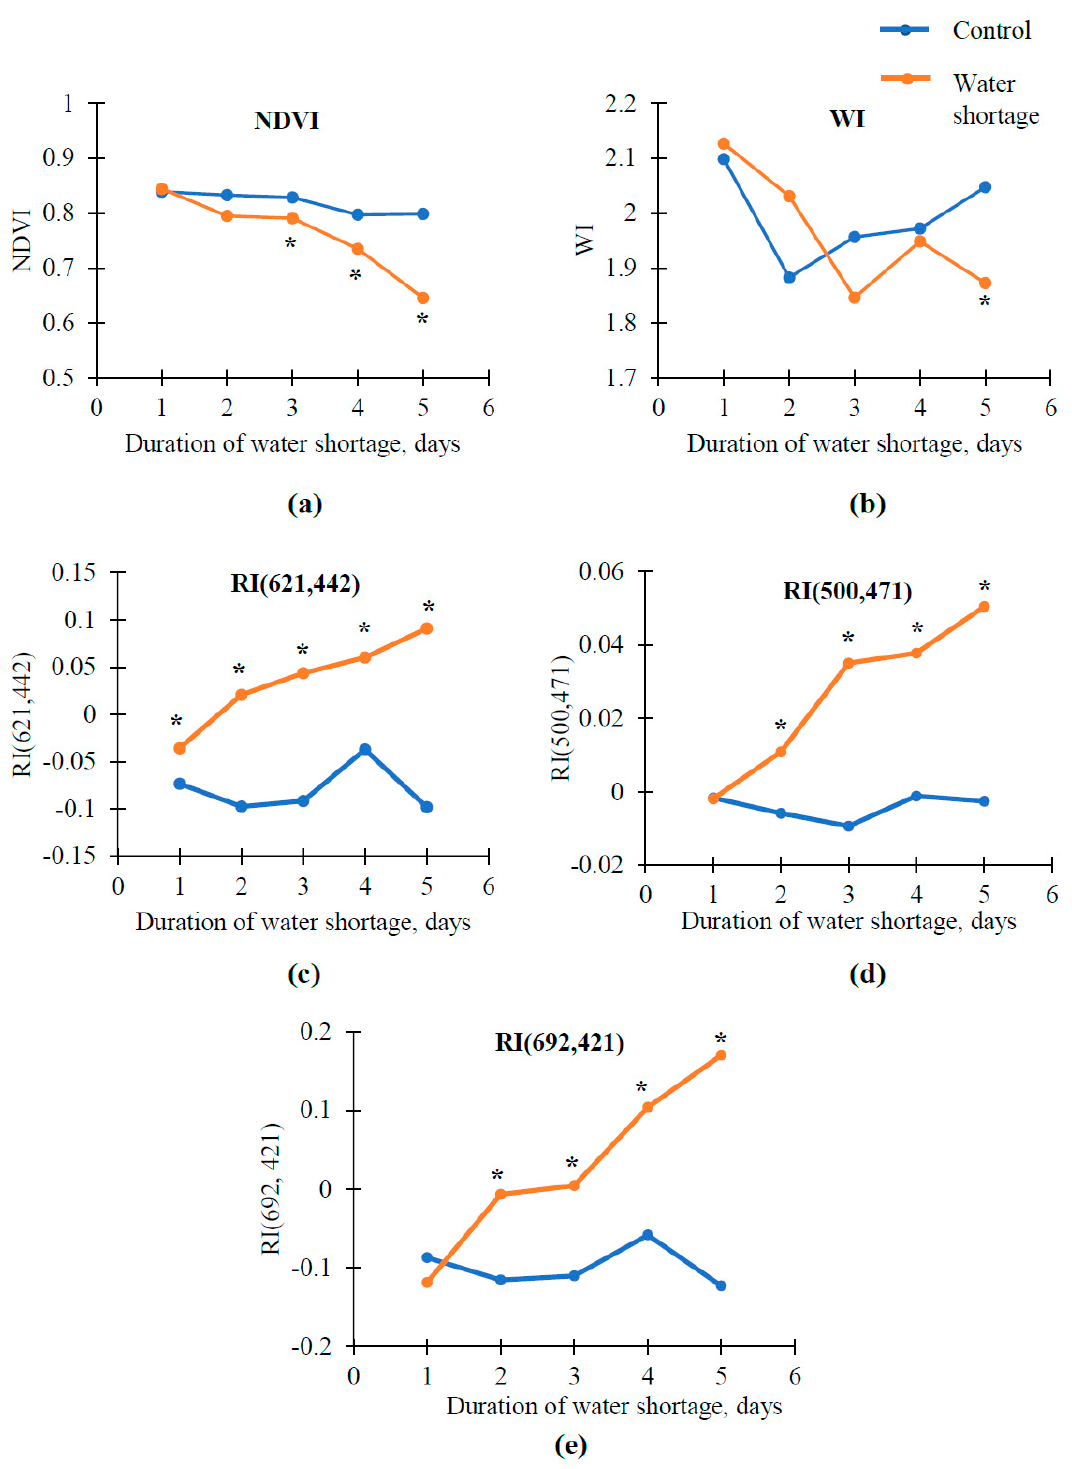
Figure 5. Dependence of ( a ) the normalized difference vegetation index (NDVI), ( b ) the water index (WI), ( c ) the difference reflectance index RI(621,442) was calculated based on R 1 = 621 nm and R 2 = 442 nm, ( d ) the difference reflectance index RI(500,471) was calculated based on R 1 = 500 nm and R 2 = 471 nm, and ( e ) the difference reflectance index RI(692,421) was calculated based on R 1 = 692 nm and R 2 = 421 nm for pea seedlings over duration of water shortage. Experimental plants were not irrigated; controls were irrigated every two days. Medians are shown in the figure. * Value significantly differed from control ( p < 0.05, Mann–Whitney U test).